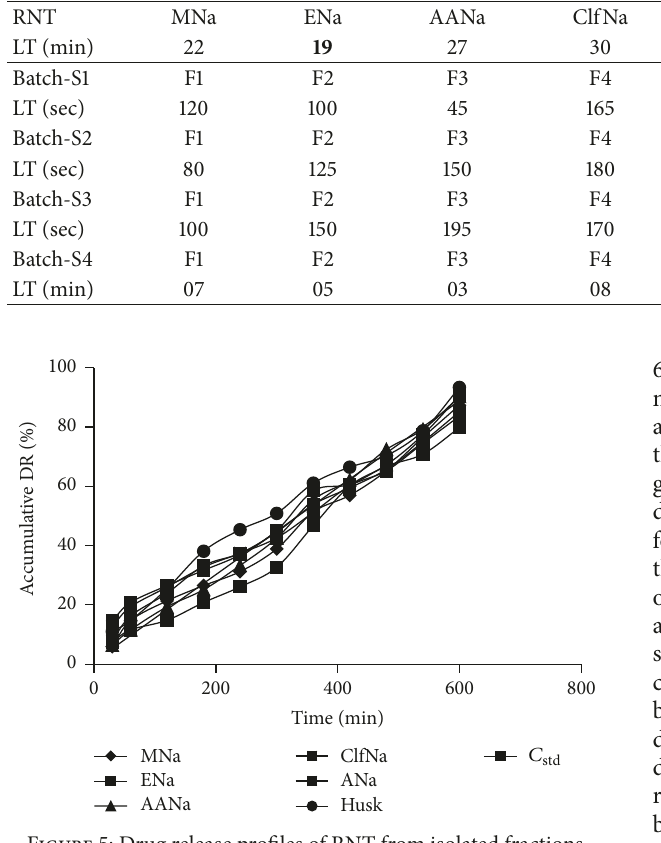
Figure 5: Drug release profiles of RNT from isolated